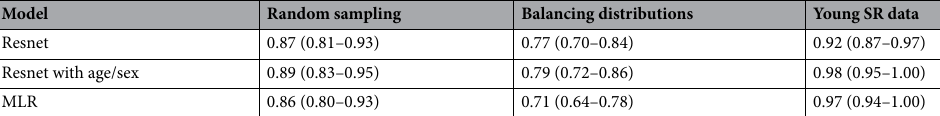
Table 2. Comparison of AUC results achieved for different models, according to different scenarios. In each scenario (random sampling, balancing distribution, young SR data) the same ECG samples have been used to train and evaluate the three different AI models. The only exception refers to MLR, where ECG samples with missing discrete values have been discarded from the analysis. AUC results are computed according to the aggregation rule by average. 95% confidence intervals are reported in brackets. ECG Electrocardiogram, MLR Multivariate Logistic Regression.